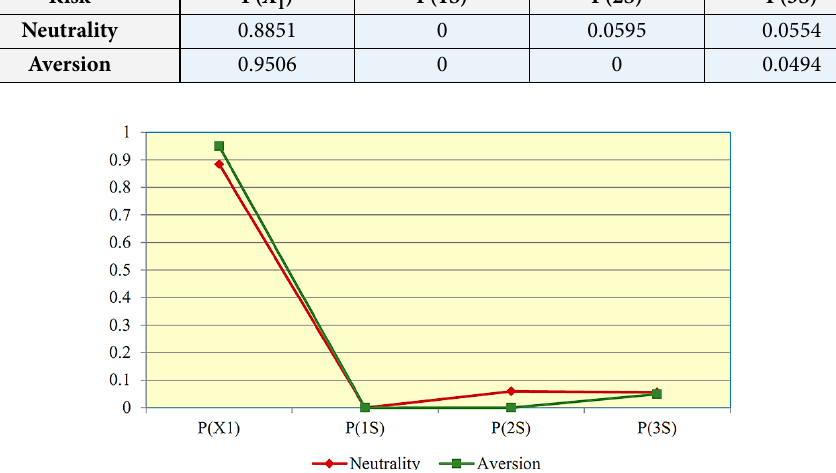
Figure 11. Equilibrium probabilities in the early stages of market